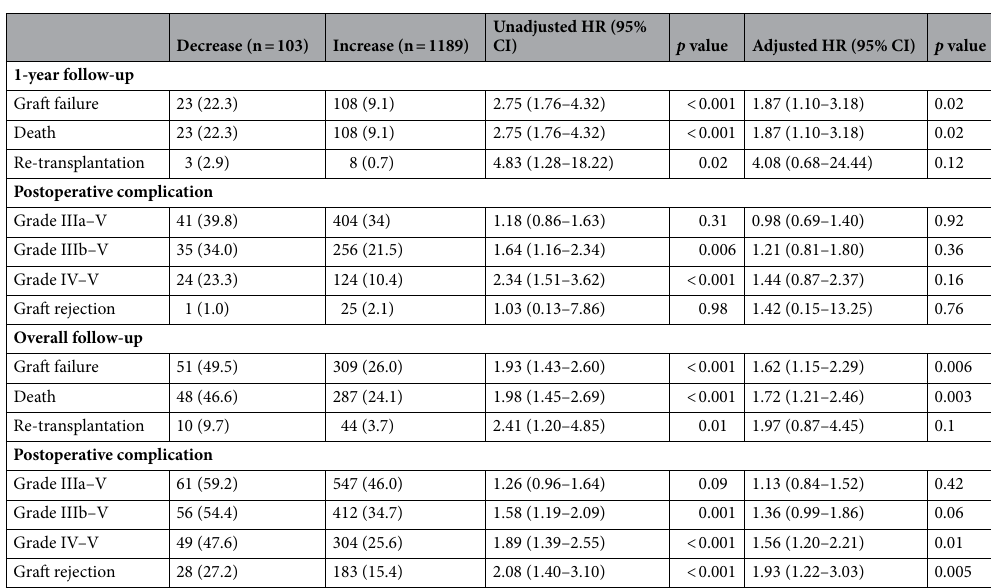
Table 2. Clinical outcomes of the entire population. Values are n (%) or mean (± SD). HR hazard ratio, CI confidence interval, IIIa complications requiring interventions without general anesthesia, IIIb complications requiring interventions under general anesthesia, IV life-threatening complications, V death. Variables for multivariable adjustment included age, sex, model for end-stage liver disease score, operative duration, alcoholics, hepatorenal syndrome, hypertension, preoperative intensive care unit treatment, viral disease, cirrhotic disease, hepatocellular carcinoma, preoperative neutrophil-to-lymphocyte ratio > 4, donor sex, and donor age.